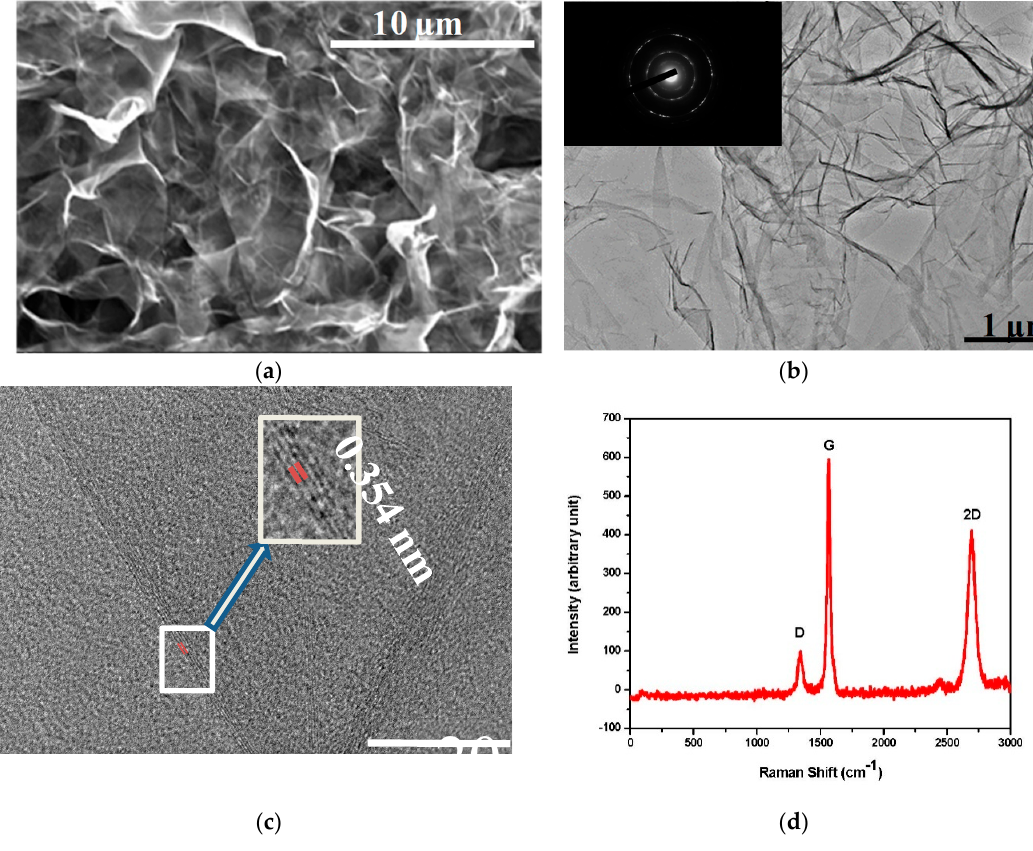
Figure 1. ( a ) SEM image of nitrogen-doped three-dimensional graphene (N-3DG) (sample H1) showing interconnected graphene flakes. ( b )TEM image of sample H1 with diffraction pattern (inset). ( c ) HRTEM image showing graphene layers. ( d ) Raman spectrum of sample H1 showing pronounced presence of D peak due to N-doping.